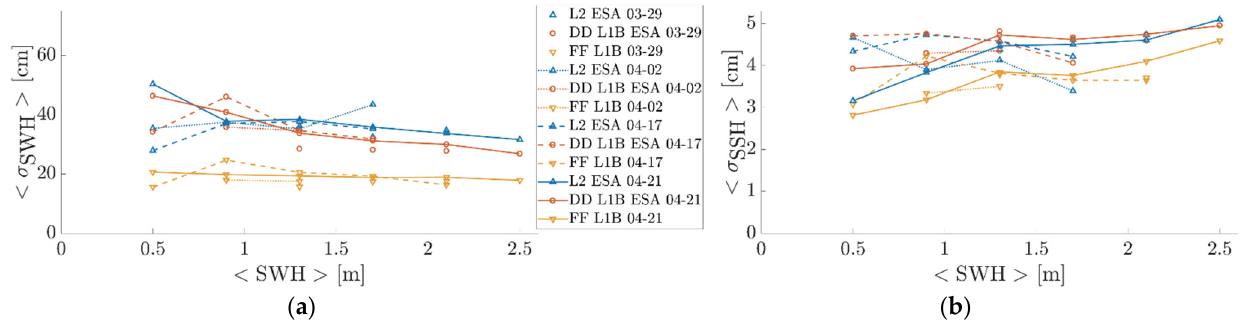
Figure 5. The precision of the selected retrieved geophysical parameters from different tracks, measured as the mean of the 20-Hz standard deviations, as a function of averaged SWH, < SWH >: ( a ) The precision of the retrieved SWH, denoted by < σ SWH >; ( b ) The precision of the retrieved Sea Surface Height (SSH), denoted by < σ SSH